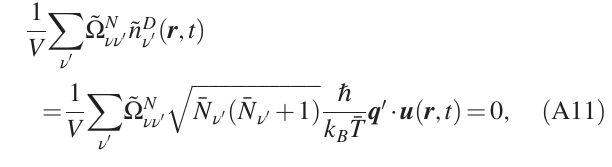
v ν ffiffiffiffiffiffiffiffiffiffiffiffiffiffiffiffiffiffiffiffiffiffiffi